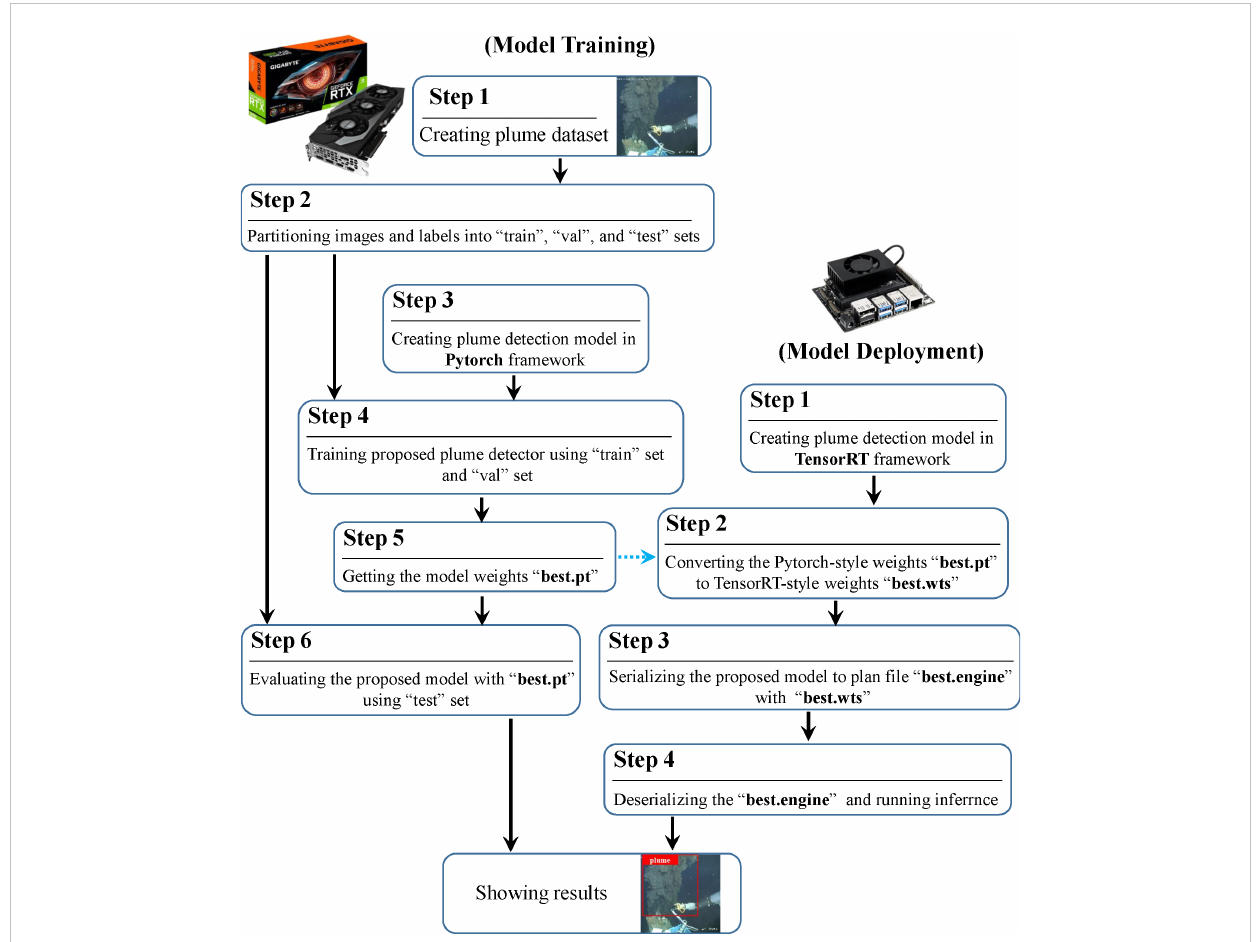
FIGURE 4 Flow chart of the proposed method, including model training (left) and model deployment (right) two